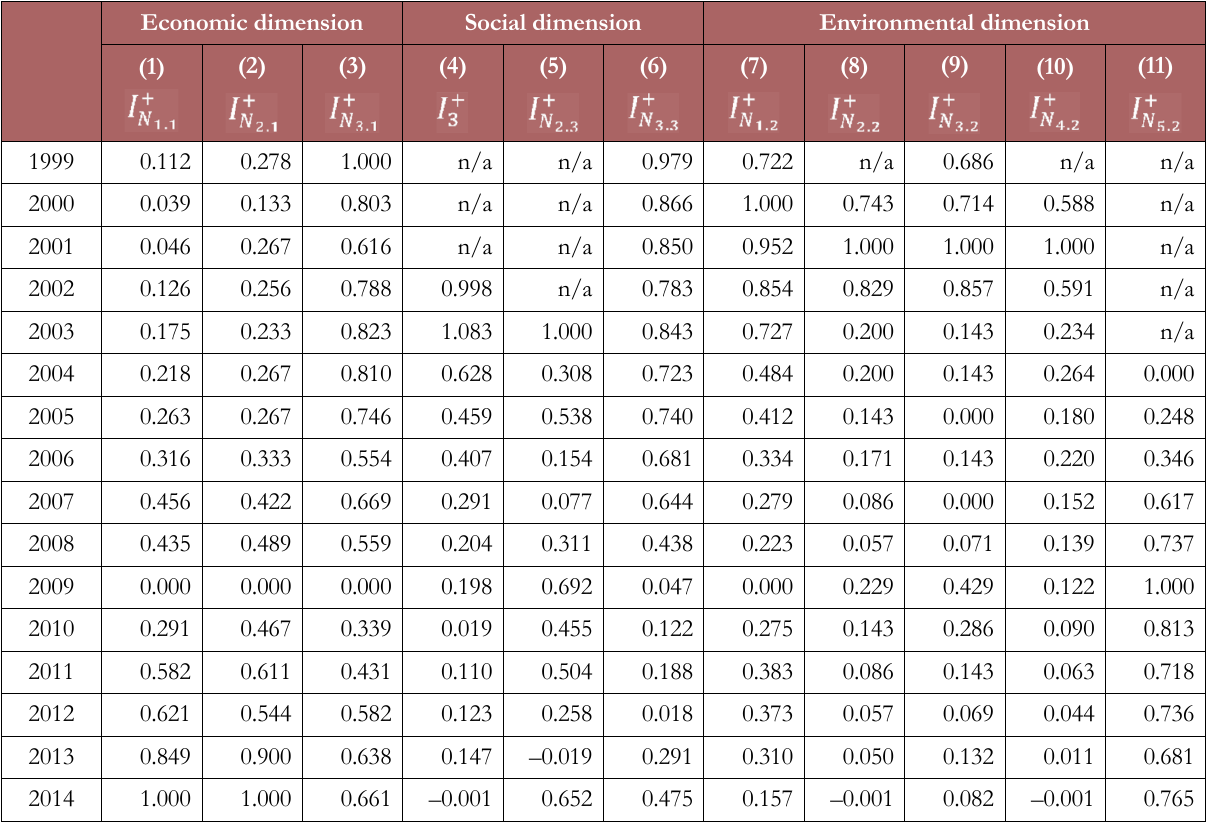
Table 4. Normalization of economic, social and environmental